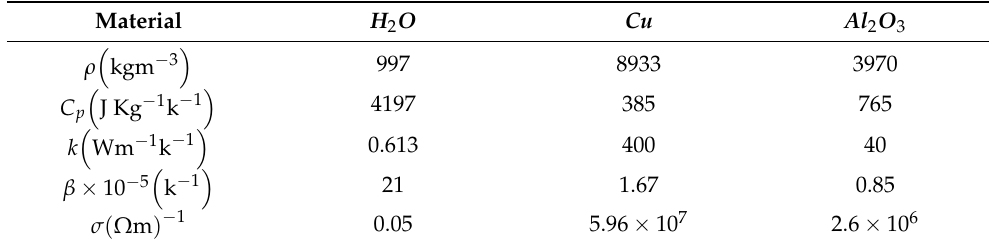
Table 1. The thermophysical properties of different base fluids and nanoparticles at room 25 ◦ C [56]. Material H 2